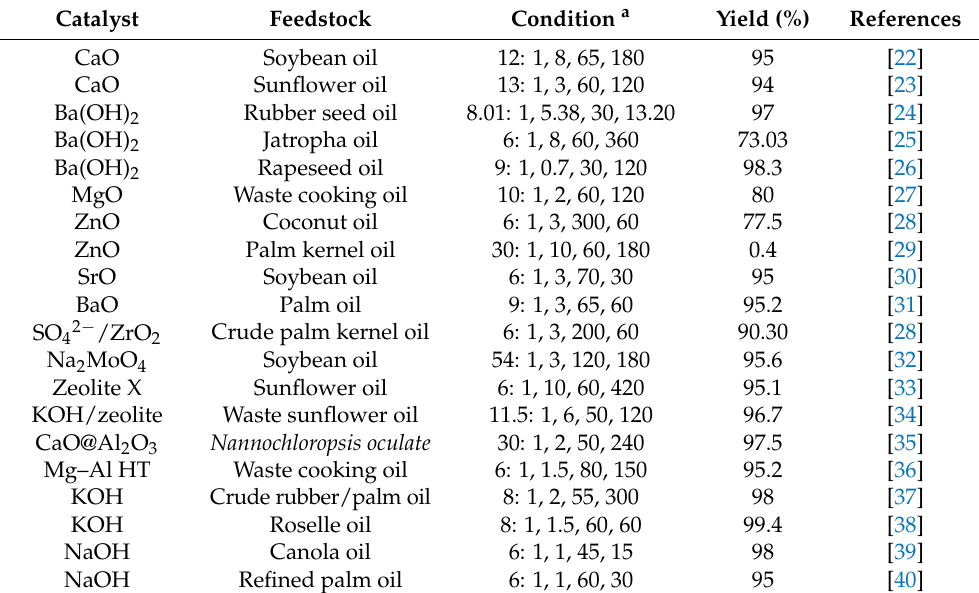
Table 1. Various heterogeneous and homogeneous-catalyzed biodiesel synthesis under diverse reaction